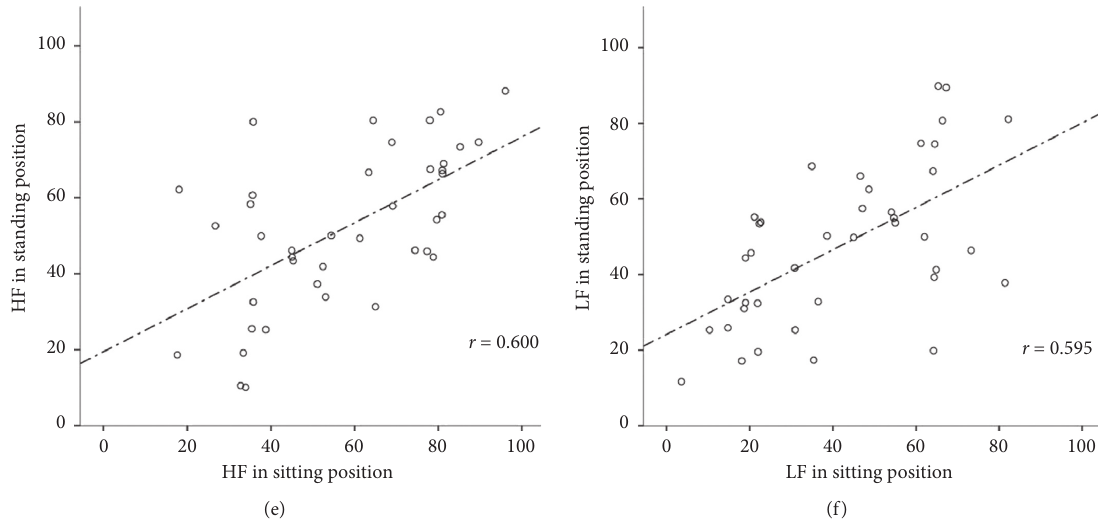
Figure 1: Pearson correlation coefficients between sitting and standing positions. (a) PNS between sitting and standing positions. (b) SNS between sitting and standing positions. (c) Mean RR between sitting and standing positions. (d) Mean HR between sitting and standing positions. (e) HF between sitting and standing positions. (f) LF between sitting and standing